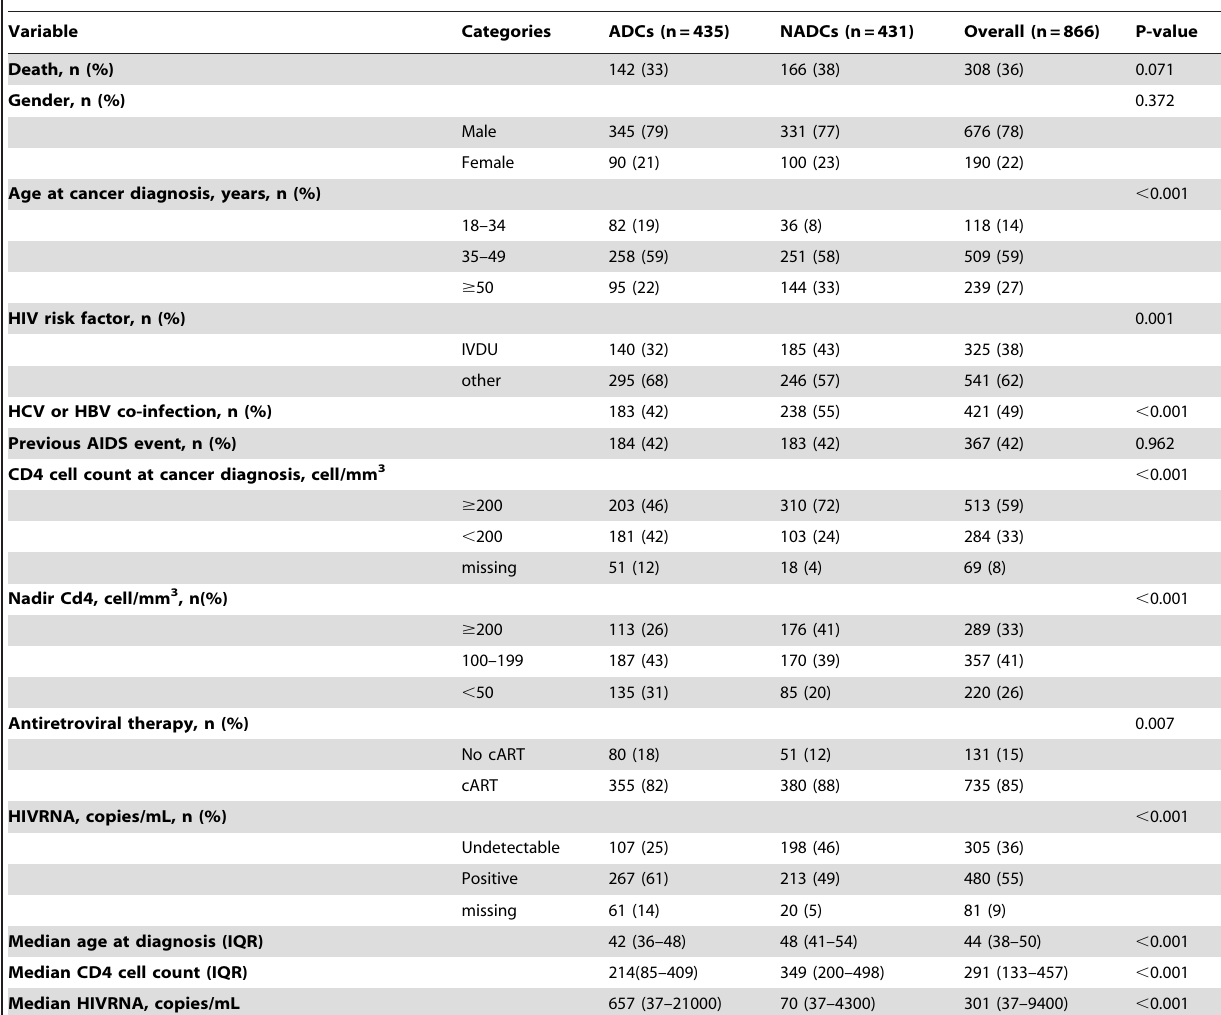
Table 1. Patients’ characteristics at cancer